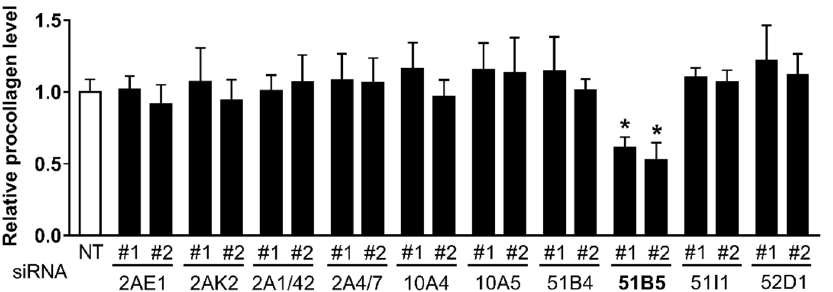
Figure 5. The knockdown of OR51B5 , among the 10 altered OR genes, decreased the collagen synthesis in Hs68 cells. The cells were transfected with NT or two distinct siRNA #1 and #2 against 10 ORs, the same as for Figure 4, and further cultured for 72 h. Type-1 procollagen was determined in the culture supernatants using ELISA. The amount of procollagen in each sample was normalized to the total cellular protein content. The results are expressed as mean ± SEM of three independent experiments. * p < 0.05.